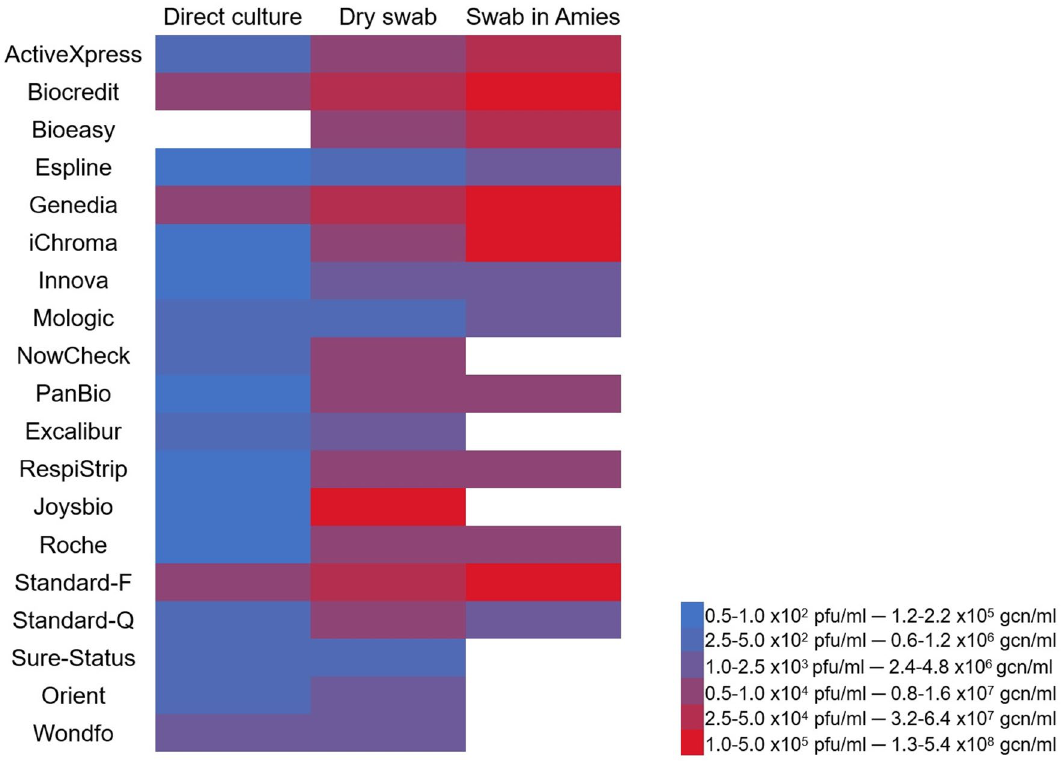
Figure 1. Heatmap of the LODs on all matrices. Ag-RDTs in direct culture matrix colored blue fulfilled WHO criteria. Note: no colored cells for direct culture indicates no Ag-RDT was tested with that matrix, no colored cells in swab in Amies swab means interference with that matrix, hence LOD is not